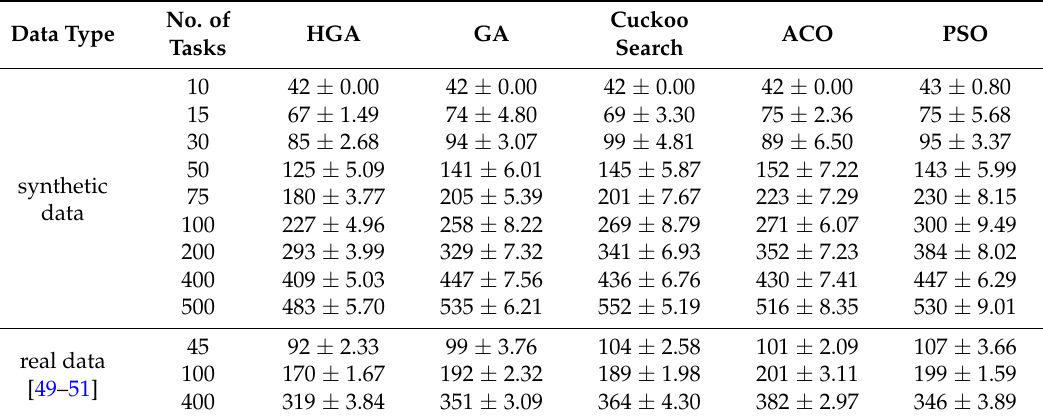
Table 3. Cost comparison of HGA, GA, CS, ACO, and PSO.